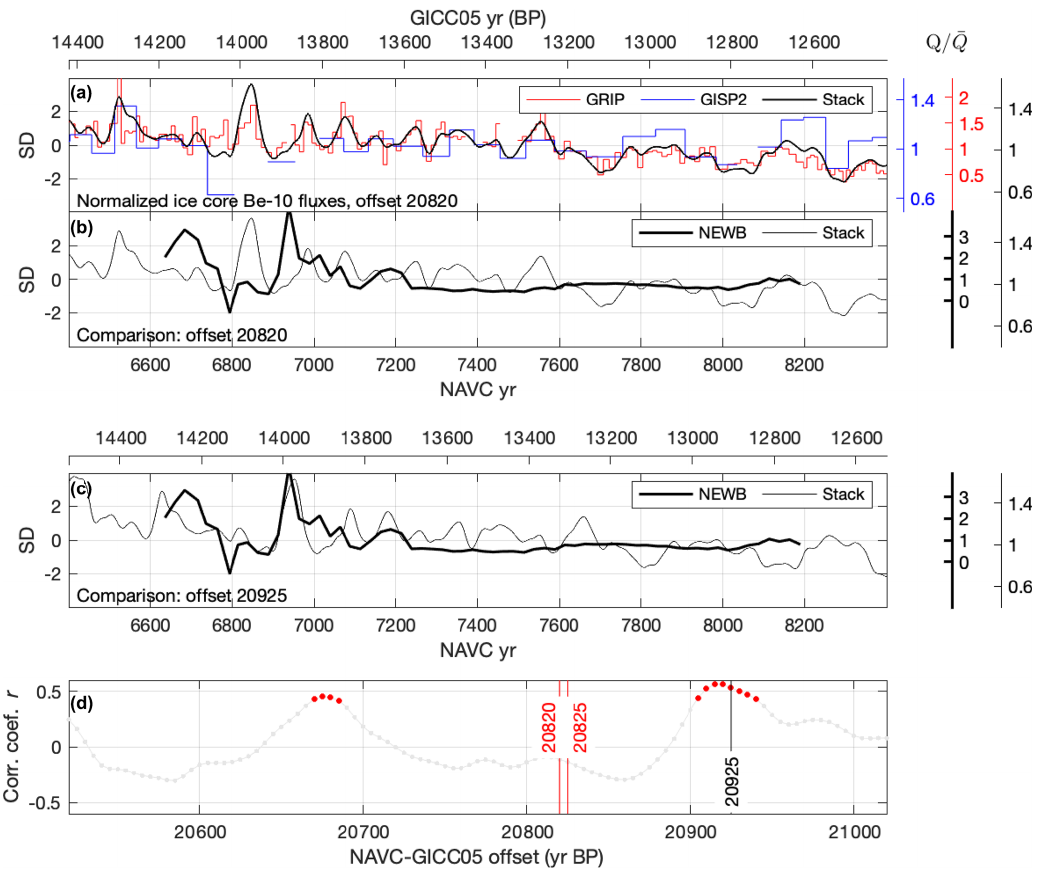
Figure 22. Comparison of the 10 Be fallout flux estimate from Newbury with ice core records of 10 Be fallout. Plot elements are the same as in Fig. 18. (a) Scaled and centered ice core 10 Be flux records from Adolphi et al. (2018), offset to NAVC years with the value of the offset inferred from 14 C data (Thompson et al., 2017) and the assumption that INTCAL13 and GICC05 timescales are equivalent in this interval. (b) Scaled and centered Newbury fallout flux estimate compared to the ice core stack for the same offset. (c) Same as (b) , only for an offset of 20925 years that aligns peaks in varve and ice core 10 Be (see text). As described in the caption to Fig. 18, the additional axes to the right of panels (a) – (c) show units of relative variation with respect to the mean of each data series. (d) Correlation between varve and ice core 10 Be records for different offset values. This considers only the glacial part of the section; the minimally variable paraglacial section does not affect the conclusions. Vertical lines highlight other suggested offsets inferred from radiocarbon calibration (20820) and event correlation (20825; see